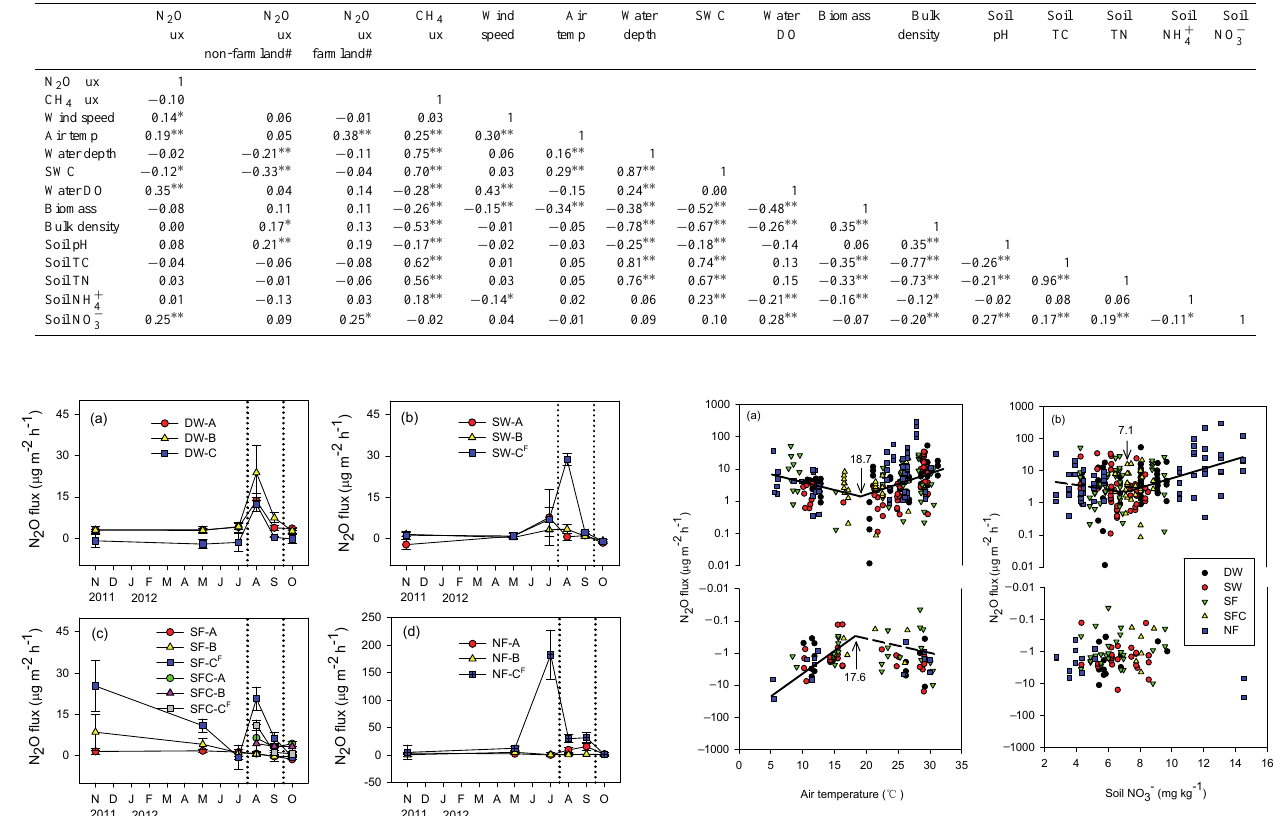
Figure 5. Monthly N 2 O flux (mean ± SE) of each site. Days be- tween dotted lines were the high water level period and thus the seasonal flooded site (SF) was under water. DW: deep water site; SW: shallow water site; SF: seasonally flooded site; SFC: “control site” for the seasonally flooded site; NF: non-flooded site. (a) , (b) and (c) denote samples from different vegetation types within each height band. Superscript F indicates farmland during the whole/part sampling time.